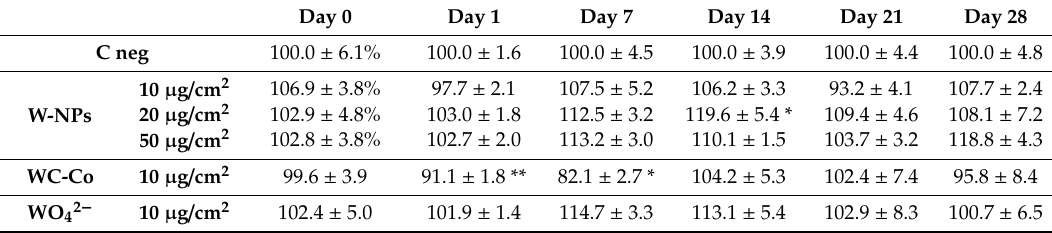
Table 2. Viability evaluation of MucilAir ™ via the analysis of the metabolic activity: Resazurin